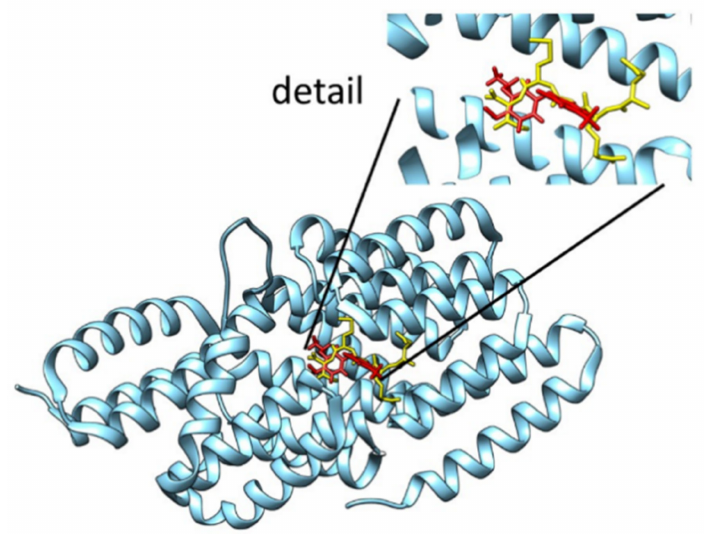
Figure 4. Molecular docking result illustrating the binding mode with the highest affinity of oxyfluo- rfen (red sticks) to phosphatase from Bacillus subtilis (blue ribbon). Oxyfluorfen binds in the same region as the inhibitory peptide (yellow sticks) that is present in the crystallographic structure of the complex.